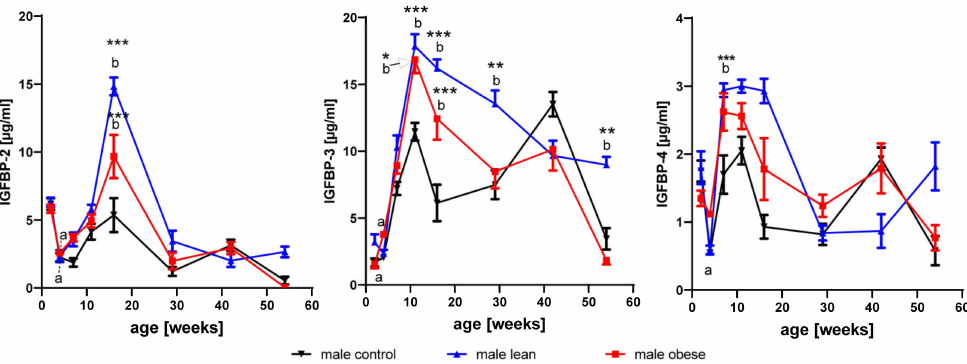
Figure 4. Concentrations of IGFBP-2, -3, and -4 in serum from male mice selected for high body weight (obese), for high protein amount (lean), and in unselected controls at an age of 2, 4, 7, 11, 16, 29, 42, and 54 weeks (mean ± SEM; n = 8 with the exception of obese male at an of 42 weeks and 54 weeks with n = 7 and n = 4, respectively; di ff erent letters (a and b) indicate significant e ff ects of age; identical letters indicate no statistically significant di ff erence also if di ff erent genetic groups were compared; *: p < 0.05; **: p < 0.01; ***: p <